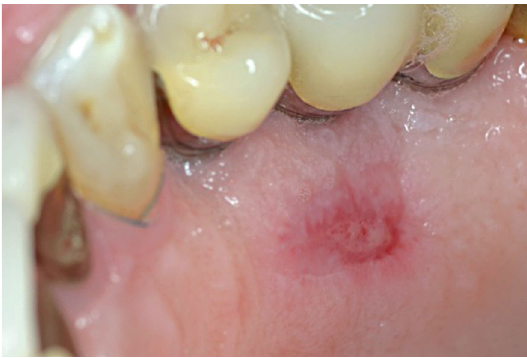
Figure 13: Palatal donor site healing after 15 days.